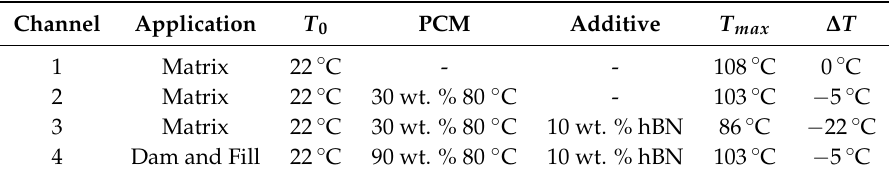
Figure 10. Temperature-time plot for different PCM enclosures on the measurement system. Each channel is heated with 1.4W. A 2512 chip resistor is used as a heater. The temperature was measured directly on the component package with a K-type thermocouple. Table 4. Experimental parameters for enclosure